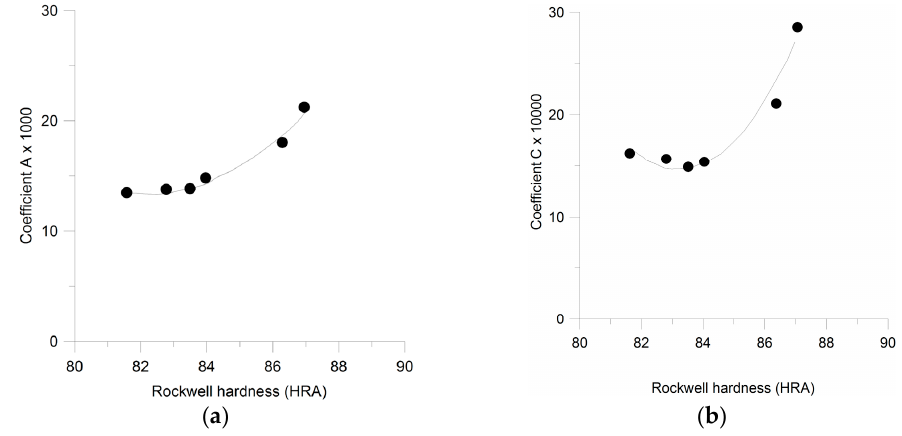
Figure 18. ( a ) Relationships between the hardness and the evaluated coefficient A and Rockwell hardness, after ref. [43]; ( b ) Relationships between the hardness and the evaluated coefficient C and Rockwell hardness after ref. [43].